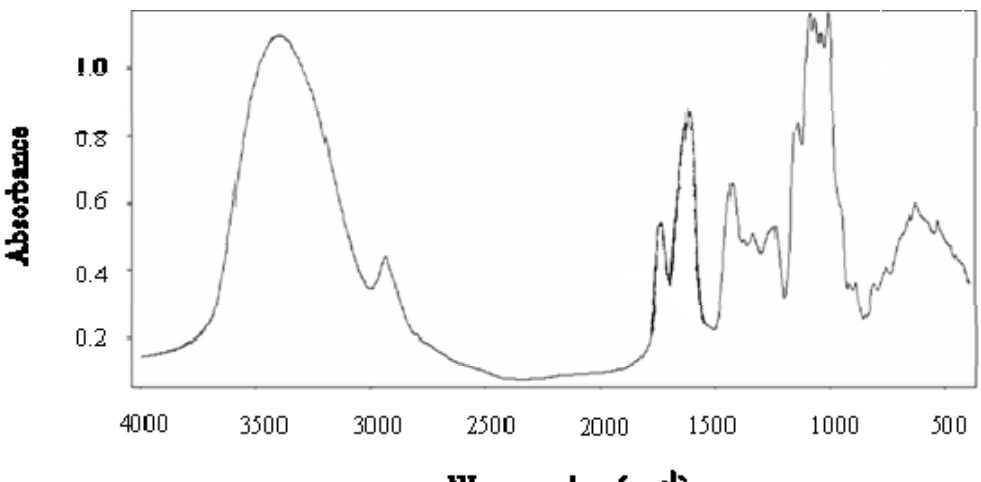
Figure 1. FTIR spectrum of Cicer arietinum L.